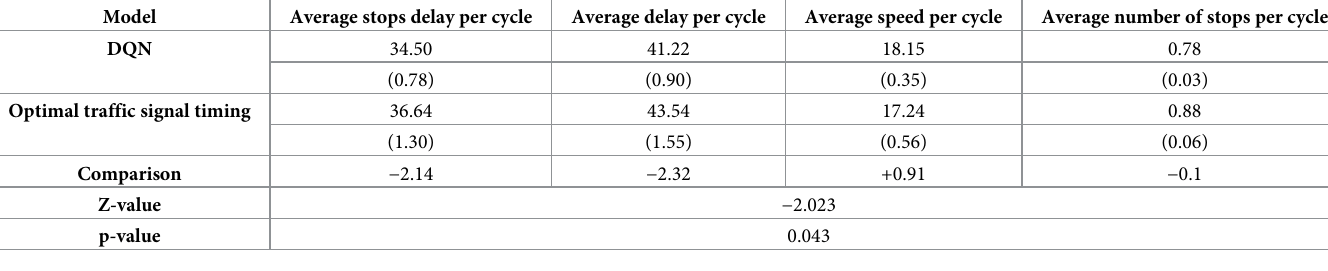
Table 6. Evaluation and validation results of scenario 2–2 in coordinated intersections.